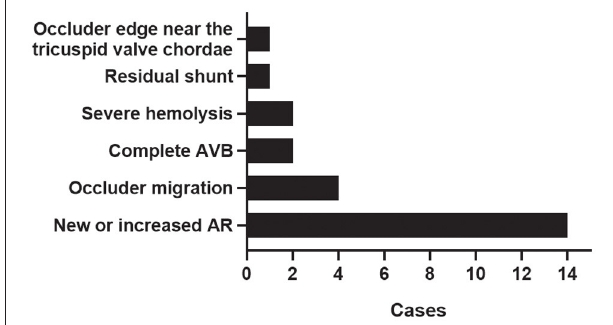
FIGURE 2 | Causes for unplanned surgery. AVB, complete atrioventricular block; AR, aortic